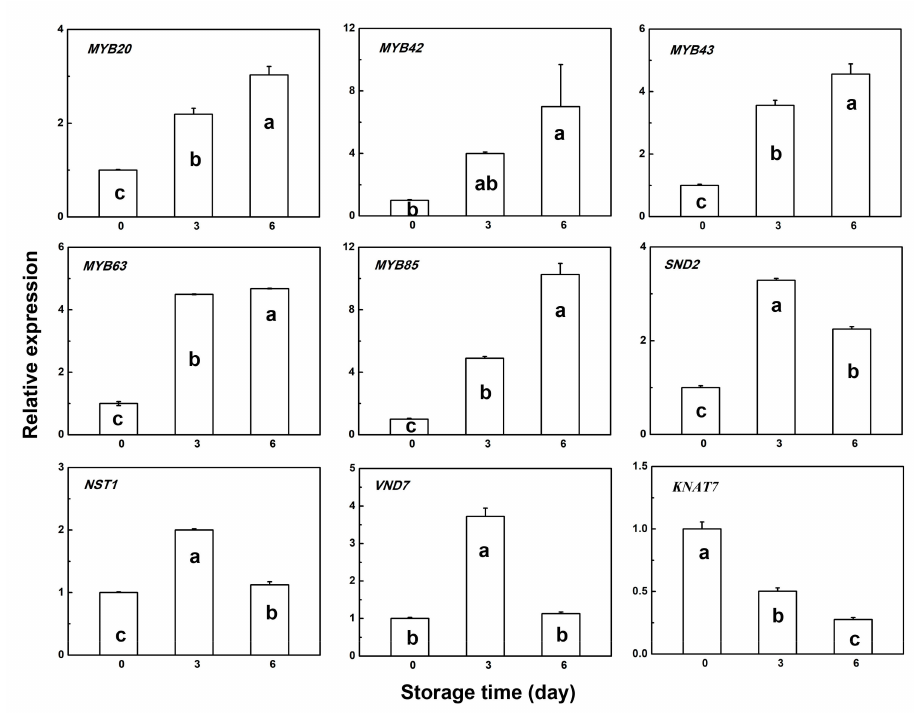
Figure 5. Relative gene expression patterns of transcription factors in HBSes during storage at 25 ◦ C. Error bars indicate the standard error. Lowercase letters indicate significant di ff erence ( p < 0.05) among various storage times in HBSes.